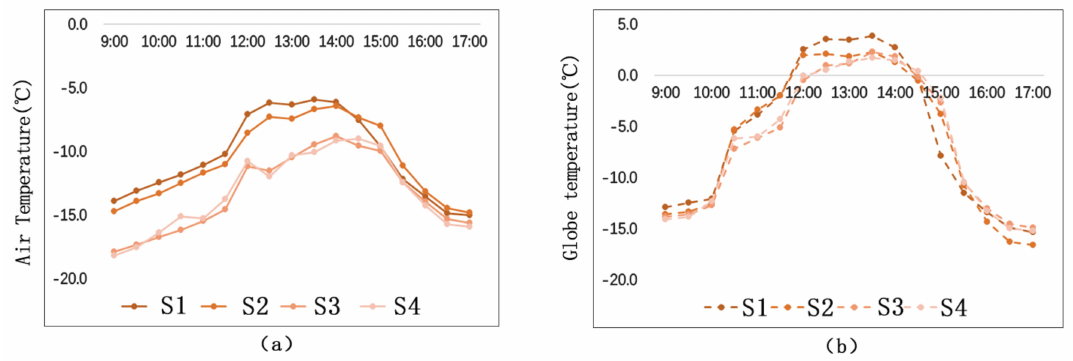
Figure 18. Temperature comparison among di ff erent measuring points of di ff erent distances: ( a ) Ta; ( b )